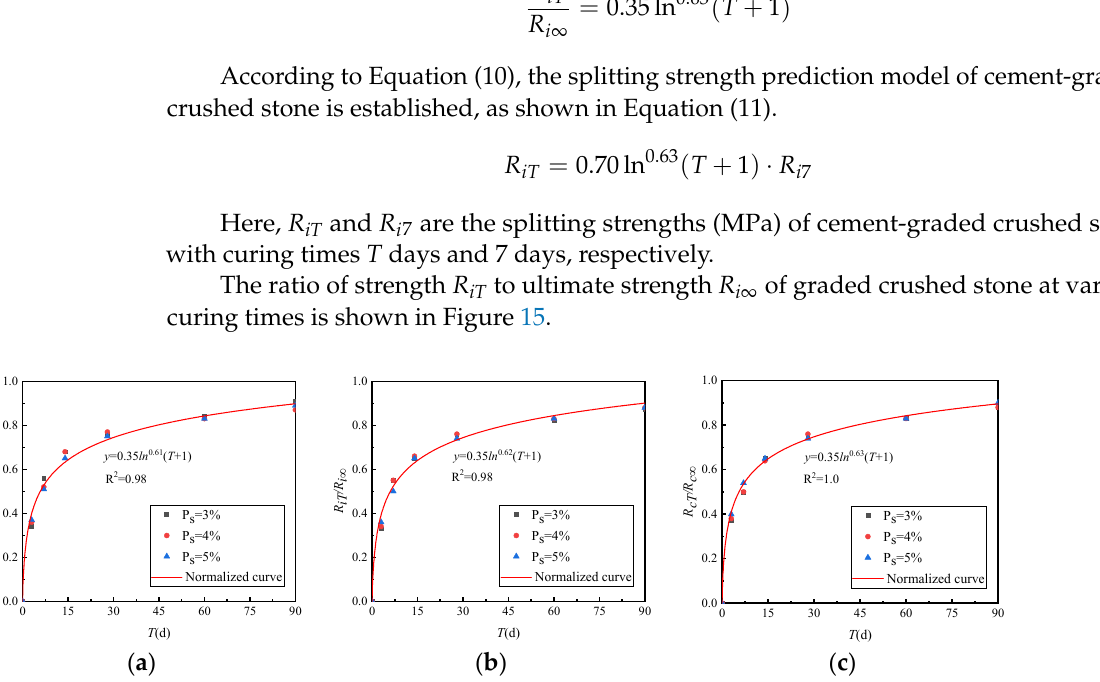
Table 10. Resilience modulus growth equation parameters.